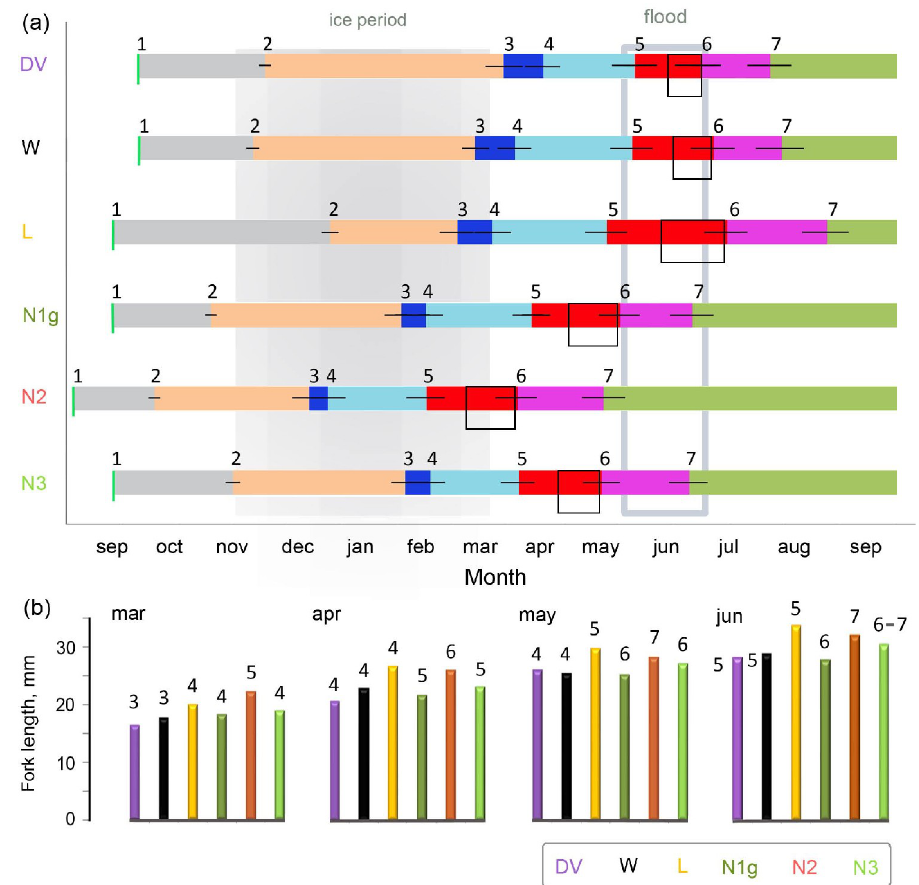
Fig 4. Timing of sequential developmental stage transition in the first year of life ( a ; lines indicate time limits of the developmental stage change, boxes stand for a probable time of leaving the redds = 50% yolk suck desorption at starvation) and early ontogeny linear growth ( b ; the morphs are shown in different colors) of the Lake Kronotskoe charr morphs and Dolly Varden based on the data obtained from the experimental rearing. The numbers mean: 1 – fertilization (peak of spawning), 2 –embryo eye pigmentation, 3 –free embryo (hatching), 4 –late embryo, 5 –alevin (and the start of feeding in the experimental conditions), 6 –late alevin, 7 –fry.